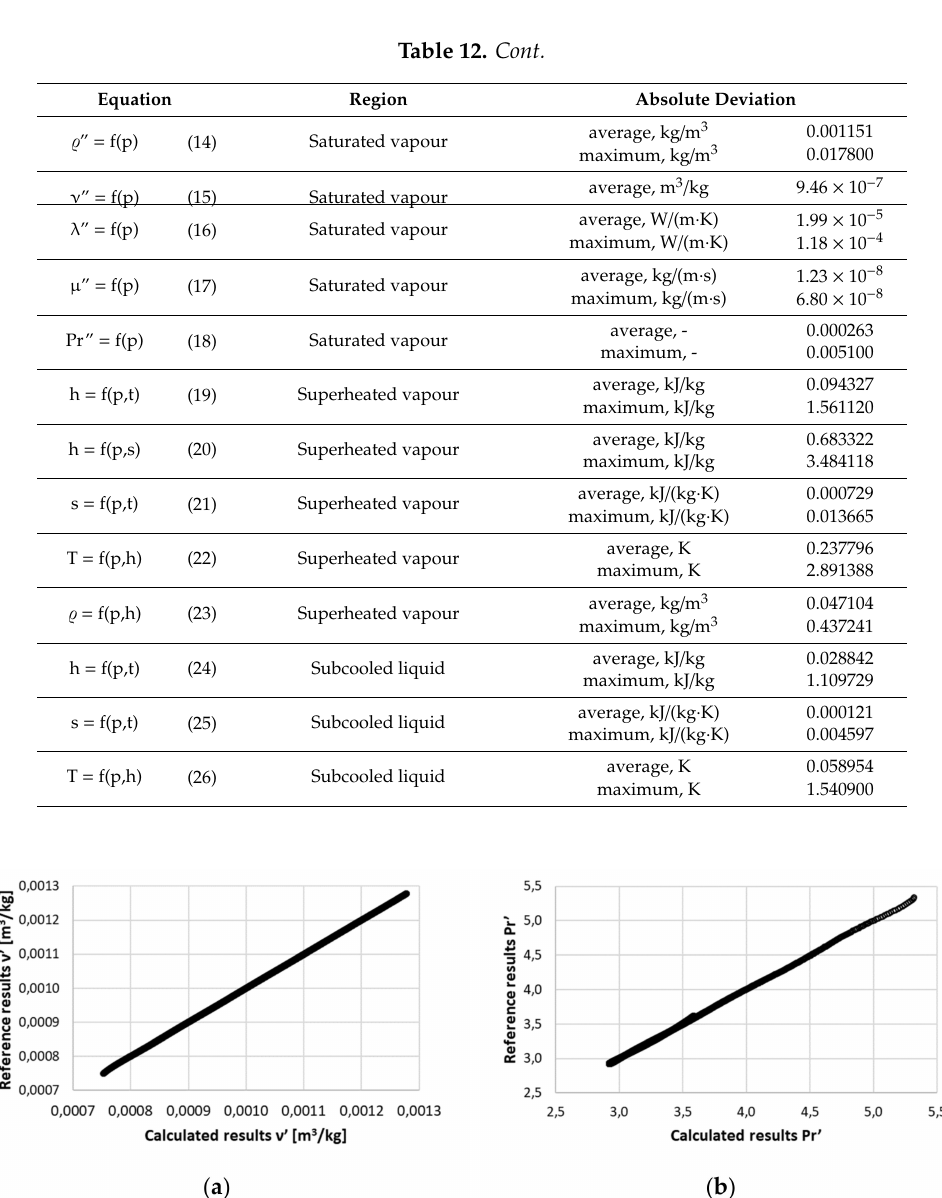
Figure 2. Comparison of the reference results and calculated results for saturated liquid: ( a ) Specific volume; ( b ) Prandtl number.